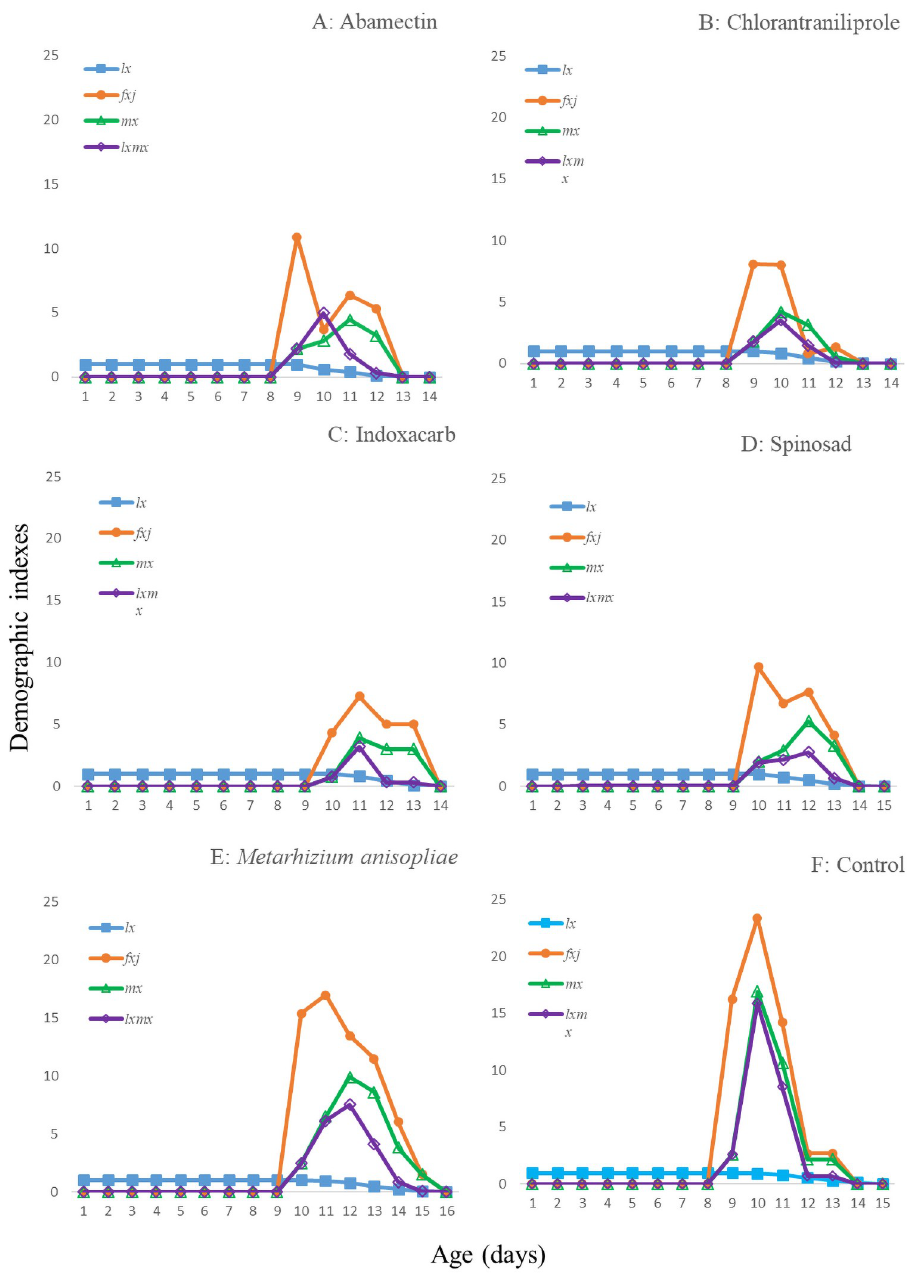
Fig 2. Age-specific survival rate ( l xj ), female age-specific fecundity ( f xj ), age-specific fecundity of the total population ( m ) and age-specific maternity ( l ) of the T . brassicae exposed to different pesticides 48 hours after x x m x spraying, A: Abamectin, B: Chlorantraniliprole, C: Indoxacarb, D: Spinosad, E: M . anisopliae , F: control. spinosad can be used as a moderately toxic compound for Vespidae and Apidae. They explained that the low penetration rate is due to cohesion with the integument and the large molecular weight of spinosad. In our study, no selectivity was observed between the parasitoid T . brassicae and its host T . absoluta . Suh et al. [91] also evaluated spinosad as a toxic com- pound for Trichogramma exiguum . Parsaeyan et al. [92] found that spinosad was the most